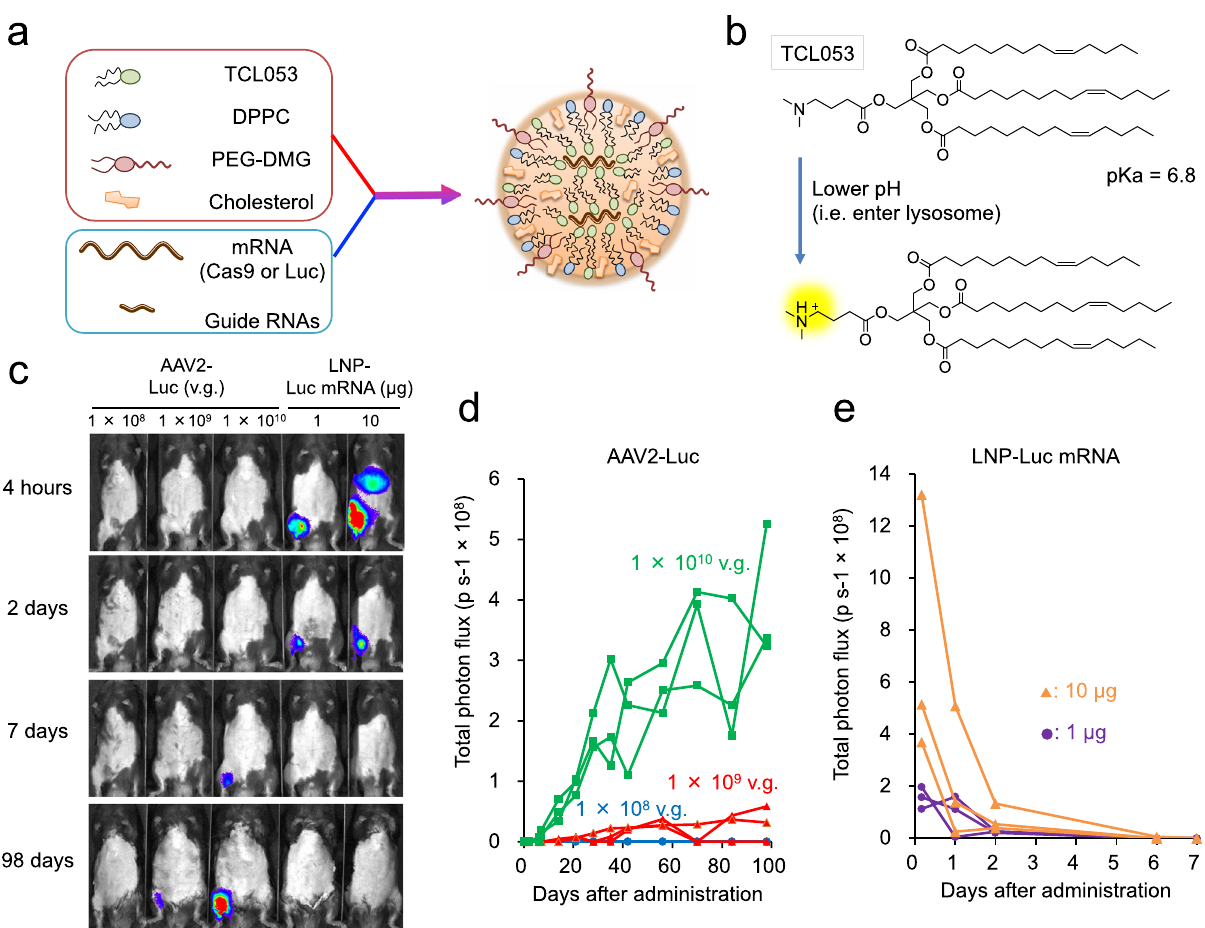
Fig. 1 LNP-mediated Luc-mRNA or CRISPR-Cas9 mRNA/sgRNA delivery into muscle tissue. a Schematic illustration of LNP-CRISPR. Either Luc mRNA or Cas9 mRNA/sgRNA is encapsulated into LNP that consists of TCL053, DPPC (Dipalmitoylphosphatidylcholine), PEG-DMG (Polyethylene glycol- dimyristoyl glycerol), and cholesterol. b Chemical structure of the newly synthesized ionizable lipid, TCL053. c Representative bioluminescence images of C57BL/6J mice after the intramuscular injection of AAV2-Luc (1 × 10 8 , 1 × 10 9 , or 1 × 10 10 v.g., vector genomes) or LNP-Luc mRNA (1 or 10 μ g mRNA). d , e Quanti fi cation of the bioluminescence signal in skeletal muscle of C57BL/6J mice treated with AAV2-Luc ( d ) or LNP-Luc mRNA ( e ). The same mice ( n = 3 mice per group) were examined repeatedly over time. Total fl ux data (p s − 1 , photons per second) are plotted as a single line per